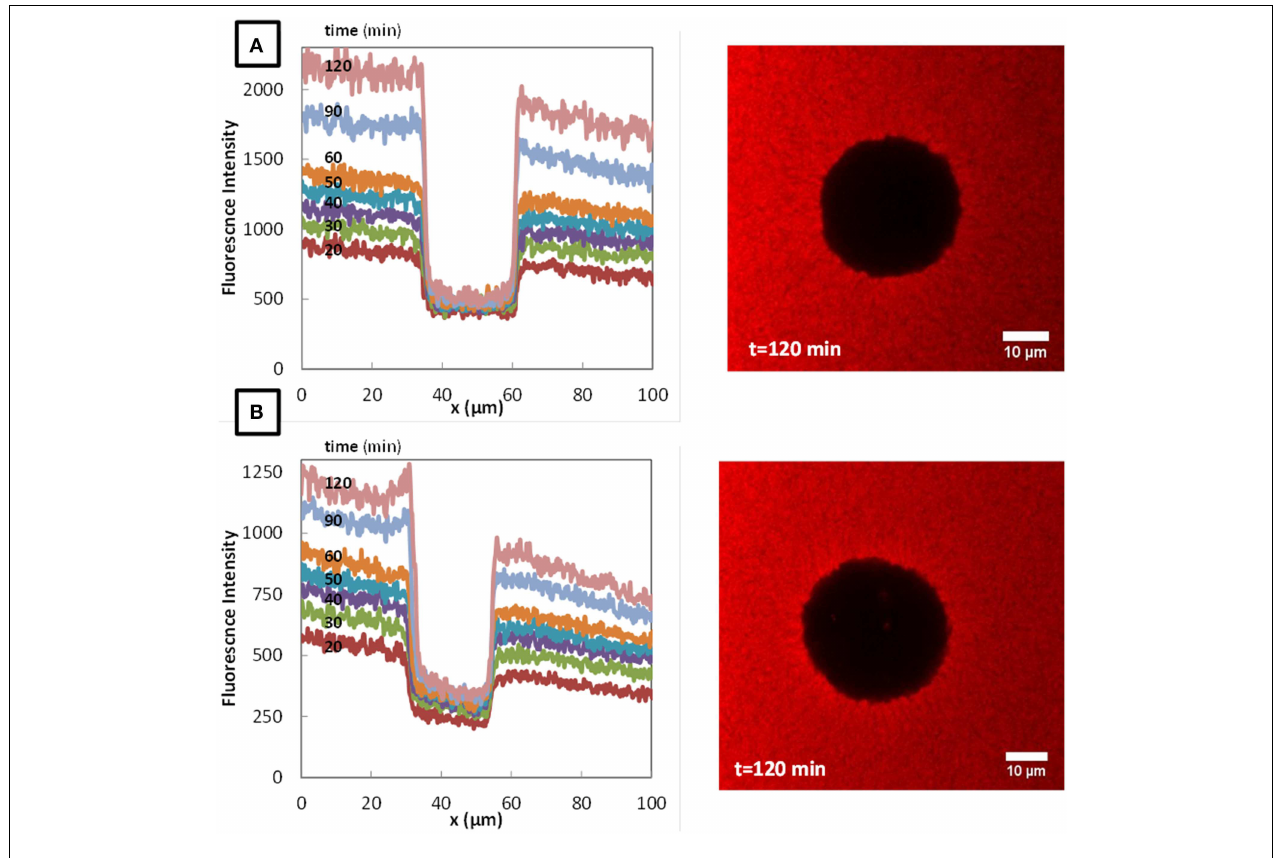
the deposit at the surface of a model cheese and the corresponding microscopic observations of the colony after 120min of